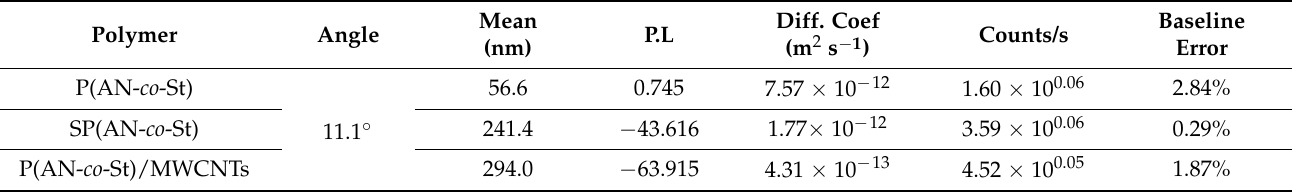
Table 2. Particle size distribution analysis of